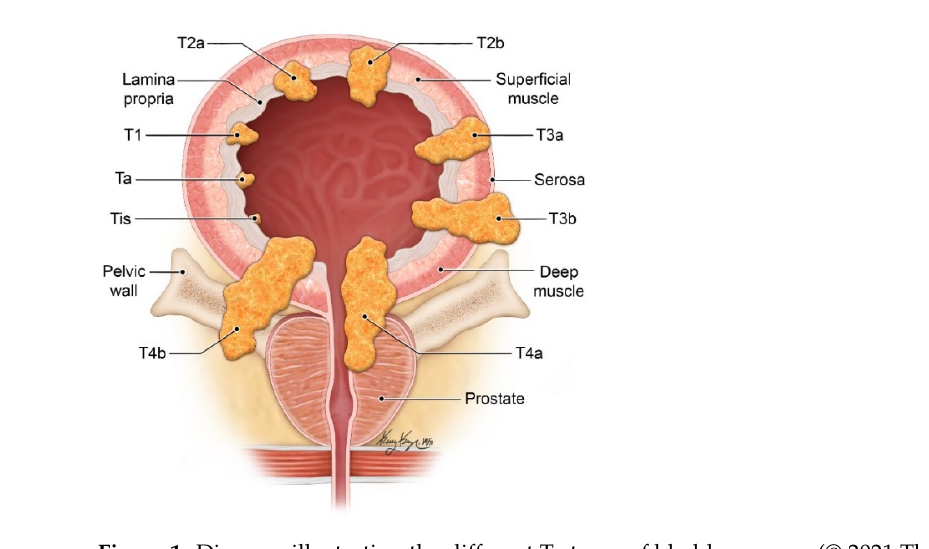
Figure 1. Diagram illustrating the different T-stages of bladder cancer. (© 2021 The University of Texas MD Anderson Cancer